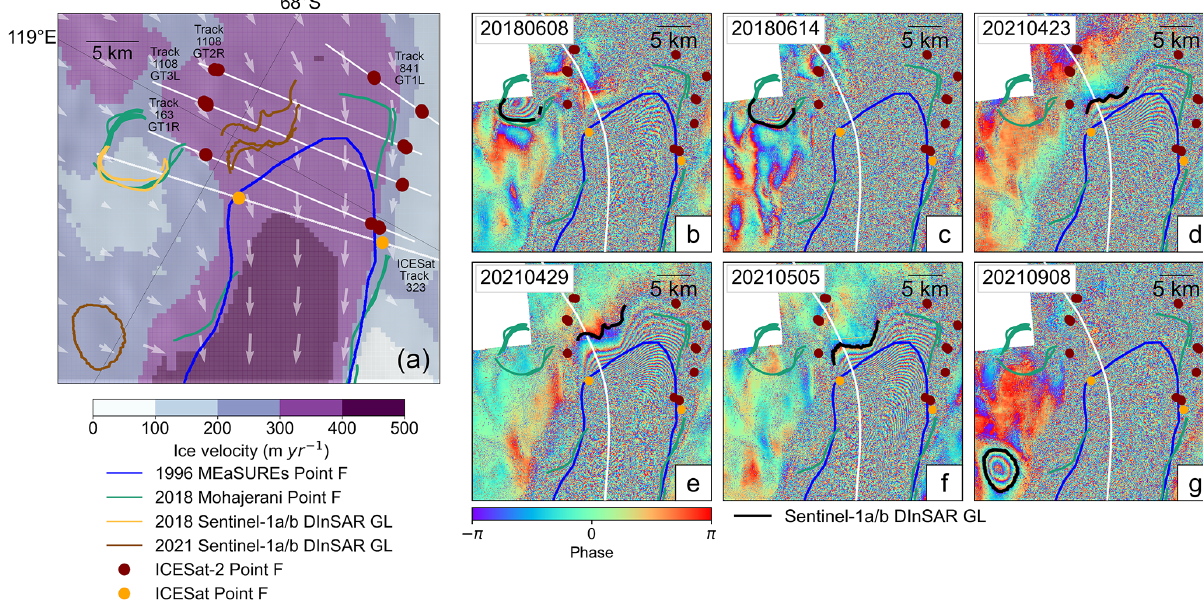
Figure 2. (a) Grounding line (GL) distributions at the main glacier trunk of Moscow University Ice Shelf (MUIS) overlaid with the ice surface velocity magnitudes and ice flow directions (white arrows) (Rignot et al., 2017). The ICESat-2-derived inland limit of tidal flexure (Point F) locations are shown as maroon dots, and the ICESat-derived Points F locations from Fig. S1 are shown as orange dots. (b–g) Sentinel- 1a/b DInSAR interferograms of MUIS between 2018 and 2021, the ice flowline is shown as the white solid line. In all subplots, the 1996 MEaSUREs DInSAR GLs (Rignot et al., 2011, 2016), and the 2018 DInSAR GLs (Mohajerani et al., 2021) are shown as blue solid lines and green solid lines, respectively. The GLs delineated from Sentinel-1a/b DInSAR interferograms in our study are shown as yellow (2018) and brown (2021) solid lines in panel (a) and black solid lines in panels (b) – (g)